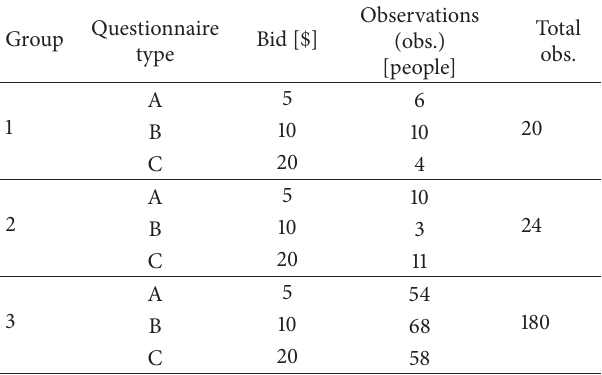
Table 2: Designed questionnaire divided by scientific background level (group number) and bid.